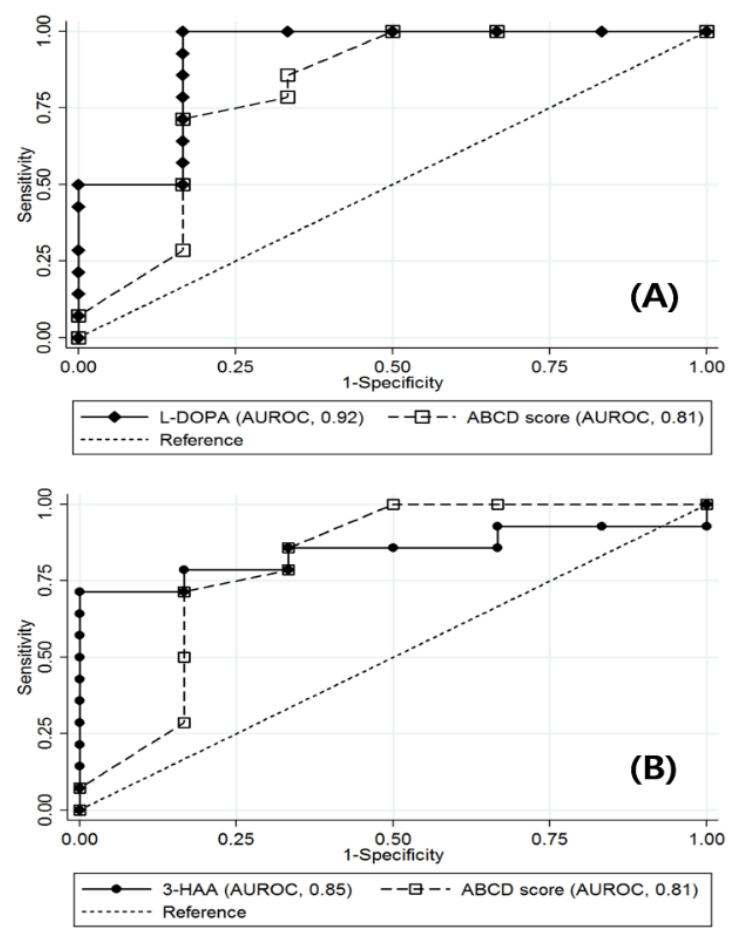
Figure 1. Prognostic performance of L-dihydroxyphenylalanine (L-DOPA), 3-hydroxyanthranilic acid (3-HAA), and the ABCD prediction model. Using 16 diabetes-related amino acid metabolites, receiver operating characteristic (ROC) curves were generated. Among the test serum metabolites, L-DOPA and 3-HAA showed superior prognostic performances with the best discrimination ability in the prediction of type 2 diabetes (T2D) remission 12 months after bariatric surgery. Figure ( A , B ) represent the different prognostic outcomes of L-DOPA and 3-HAA, respectively. AUROC, area under receiver operating characteristic curve.